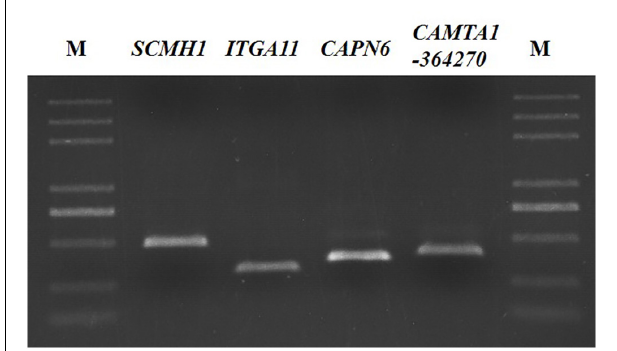
TABLE 4 | Association analysis between SNPs and yearling weight of Hu sheep.